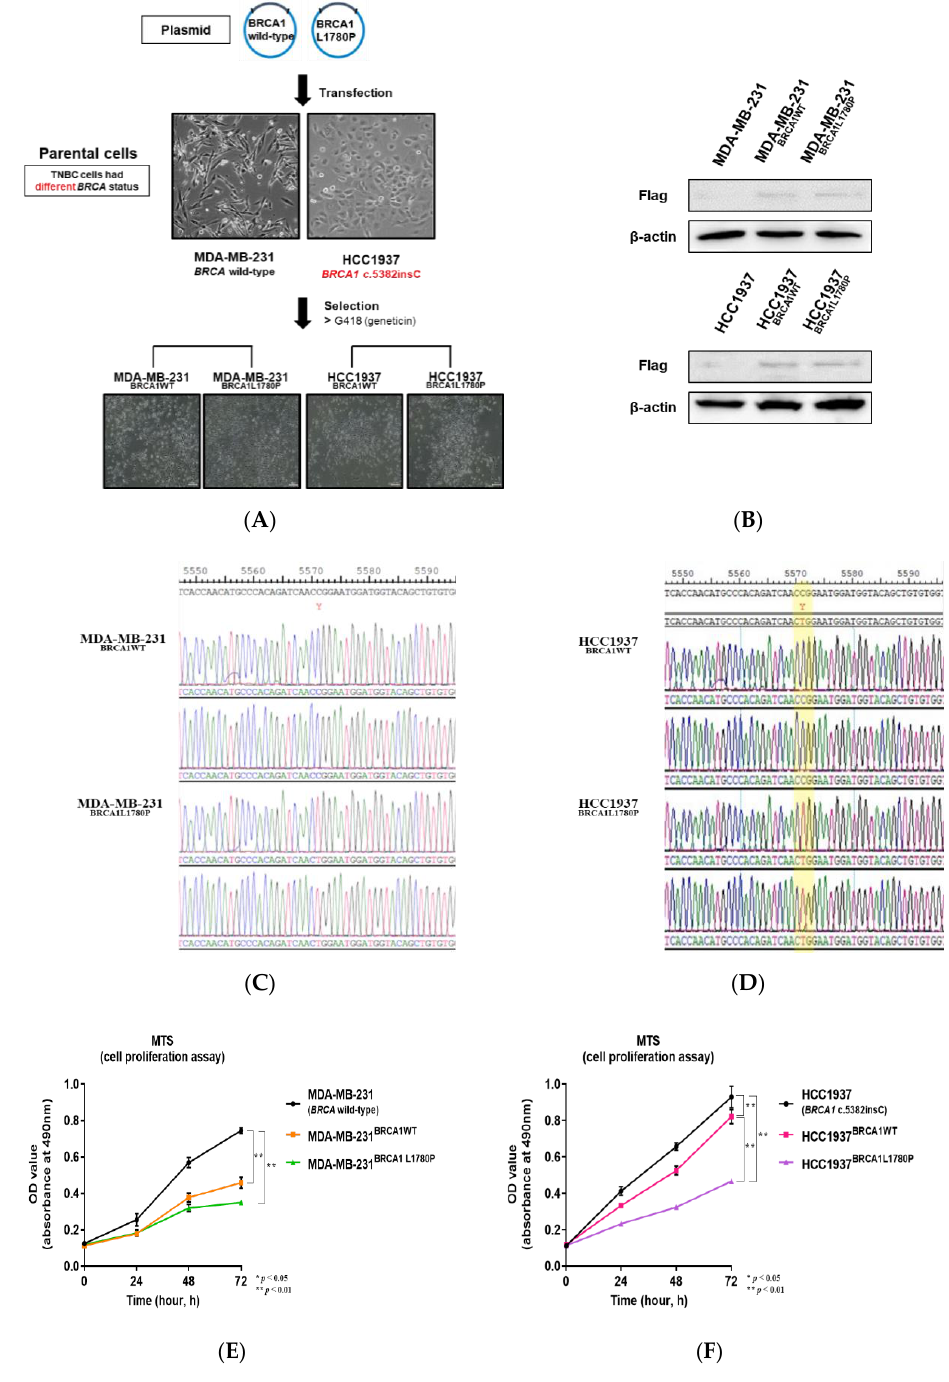
Figure 2. Stable expression of mutant BRCA1 proteins in TNBC cells. ( A ) Flowchart illustrating the establishment of TNBC cells with stable expression of mutant BRCA1 proteins. ( B ) Flag-tagged proteins were detected by Western blotting using anti-FLAG antibody. ( C , D ) Sanger sequencing was performed to confirm BRCA1 status. BRCA1 wild-type and stable BRCA1 L1780P mutant ( C ) MDA-MB-231 and ( D ) HCC1937 cells were used. ( E , F ) Cell proliferation assay was performed in ( E ) MDA-MB-231 parental and stably transfected cells; ( F ) HCC1937 parental and stably transfected cells were used to cell proliferation assay. Data are reported as the mean ± standard deviation (SD). Statistical analysis was performed using chi-square test. (* p < 0.05, ** p < 0.01).